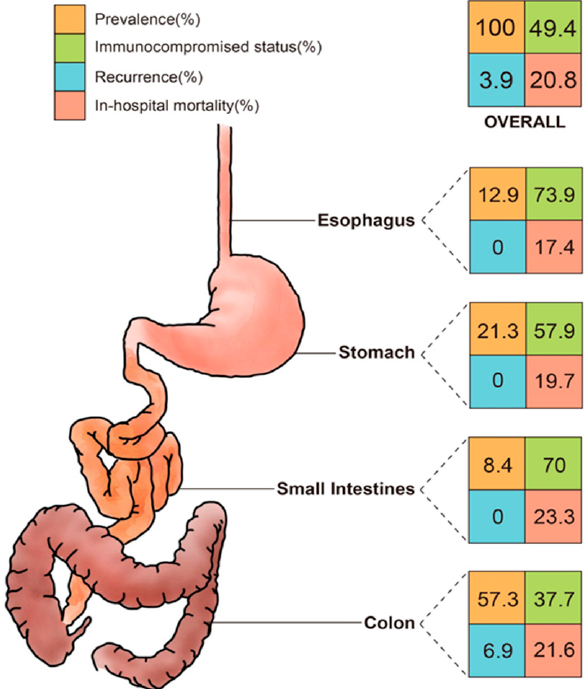
Figure 1. The percentages of prevalence, immunocompromised status, recurrence, and in-hospital mortality rates of CMV disease in different segments of the GI tract. CMV, cytomegalovirus; GI, gastrointestinal.